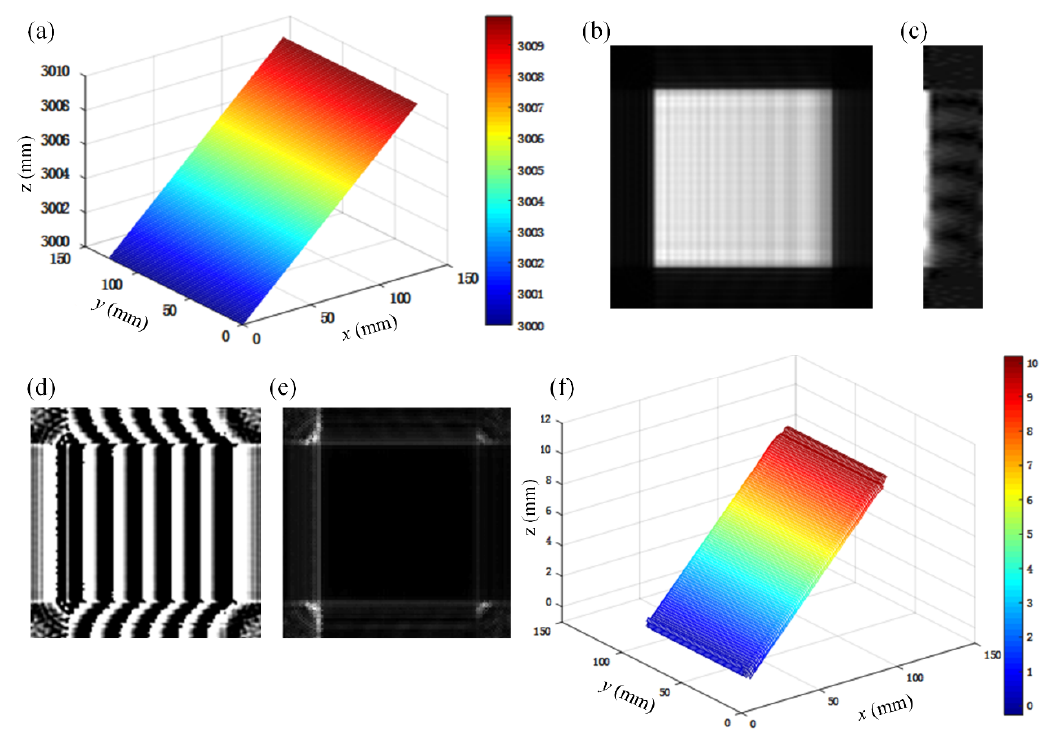
Figure 4. Range distribution experiment of inclined plane. ( a ). The inclined plane model diagram. ( b ). Range projection amplitudes obtained from traditional 3D reconstruction. ( c ). Reconstruction side view. ( d ). The phase wrapping diagram. ( e ). The phase quality diagram. ( f ). Reconstruction results obtained by phase unwrapping.